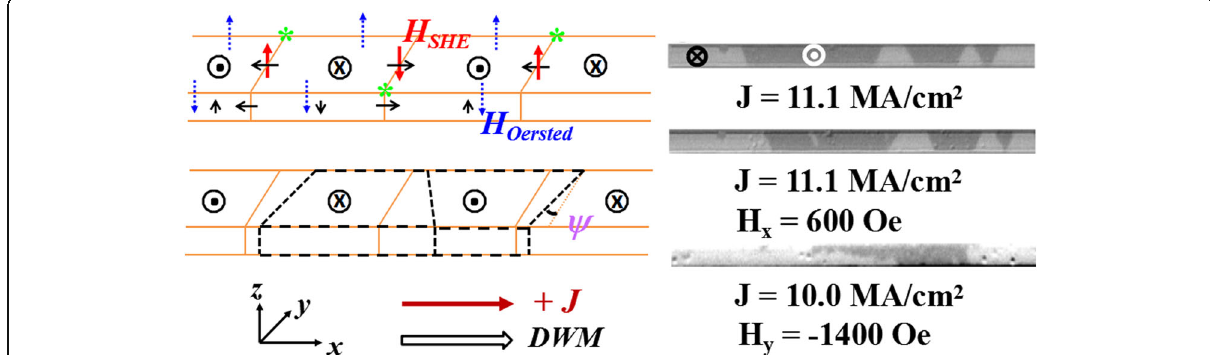
Fig. 4 Schematic DW motion and domain shapes at a current density J . The left upper panel shows the domain with U-D-U-D sketches and the magnetization orientation (thin black arrow) in domain and DWs. Once a current applied, the generated H SHE acting on the DWs are shown as red thick arrows, while the Oersted fields ( H Oersted ) at both sides of the racetrack are shown as dash blue arrows. The left lower panel shows the corresponding change of the domain shape (denoted as dash thick black blocks) under the action of H SHE and H Oersted . The right panel shows the effect of in-plane magnetic fields on the domain shape for